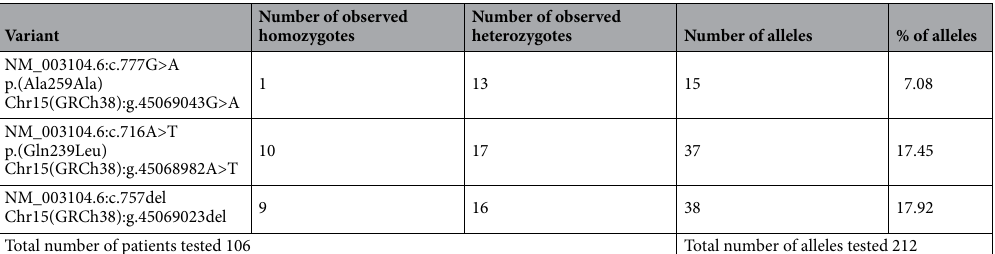
Number of observed